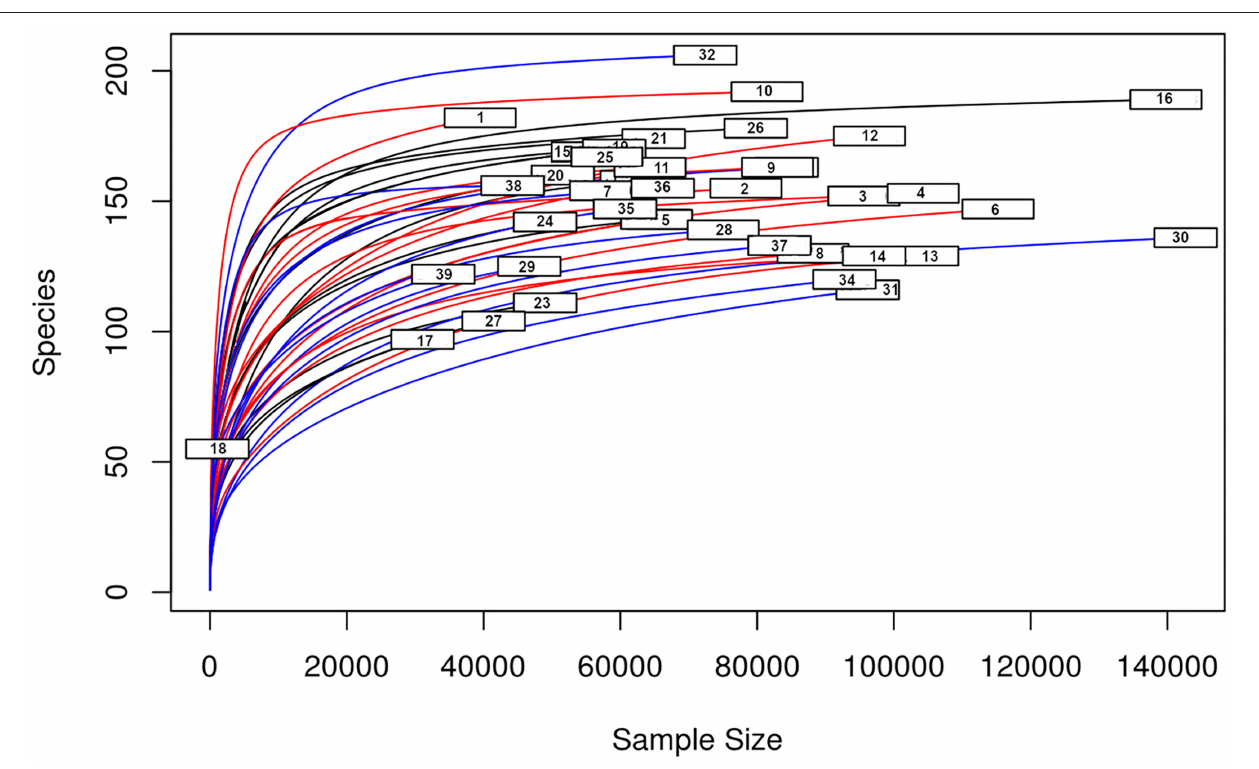
FIGURE 1 | Alpha—diversity for the entire caseload. Each line represents one sample: in blue those belonging to S group, in red the H group, in black the E_A group. On the x-axis is reported the sequences number, the y-axis represented the number of different